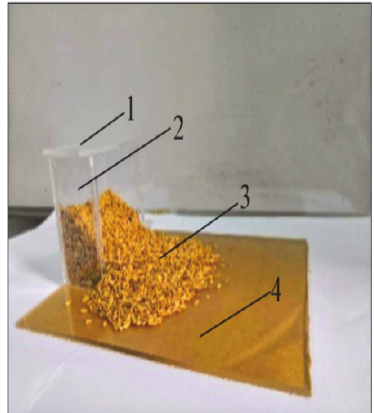
Figure 1. Simulation of dynamic stacking angle ( a ) 20 rpm; ( b ) 50 rpm [57].